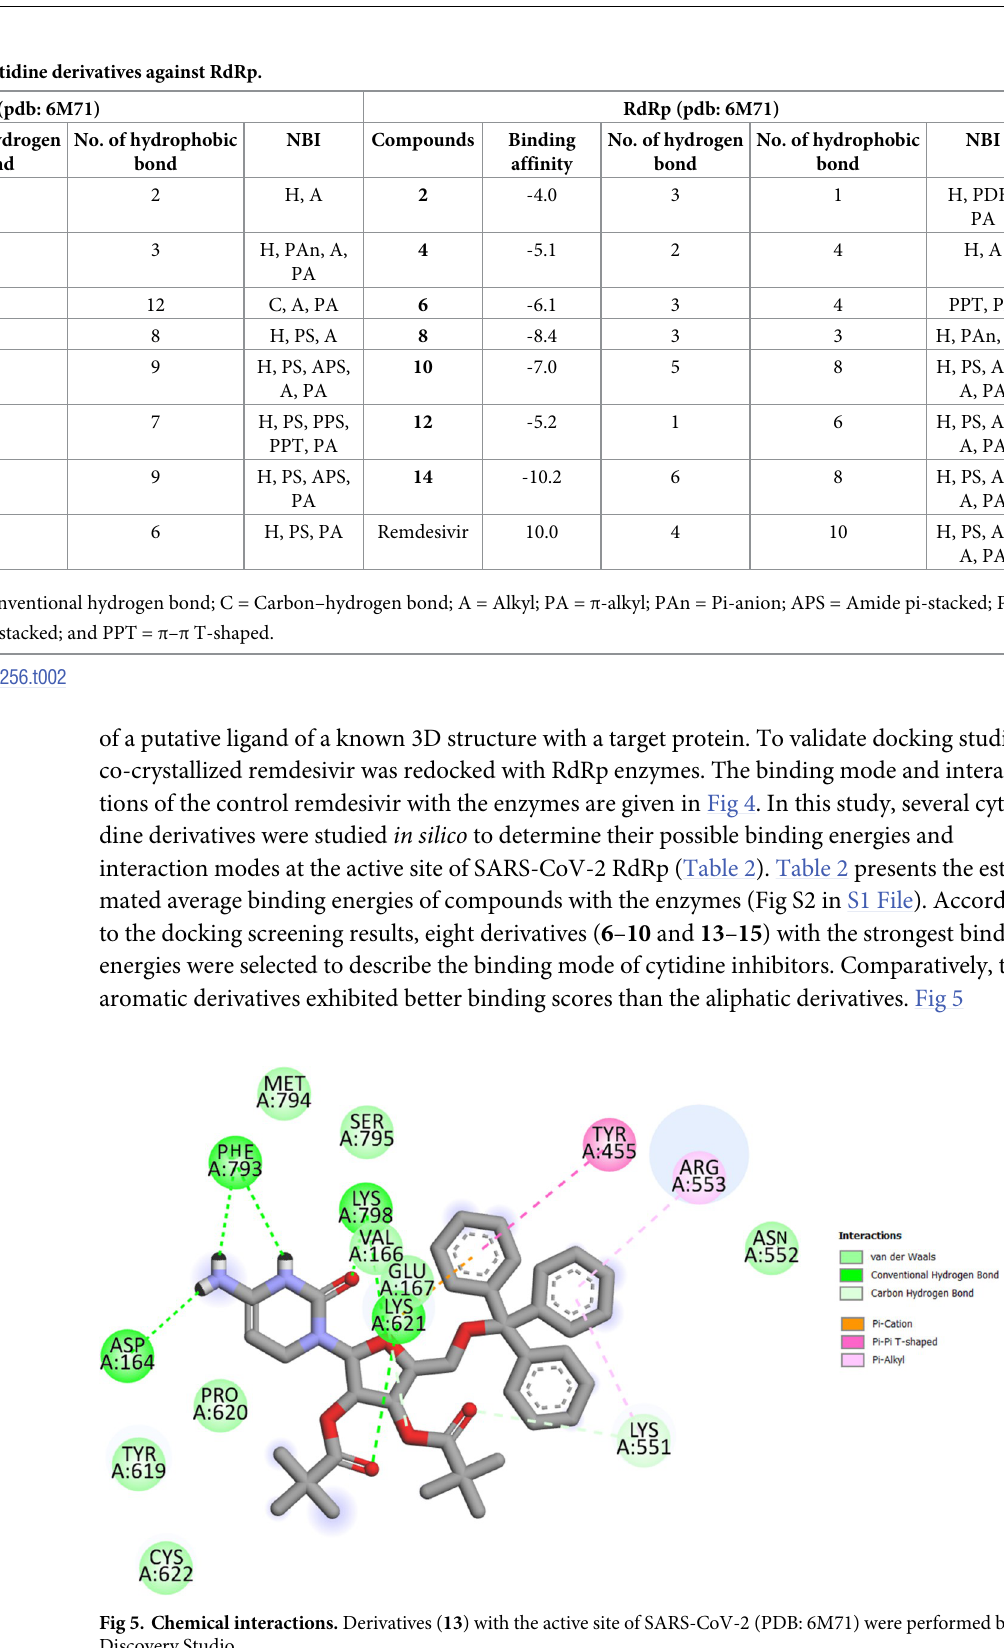
Fig 5. Chemical interactions. Derivatives ( 13 ) with the active site of SARS-CoV-2 (PDB: 6M71) were performed by Discovery